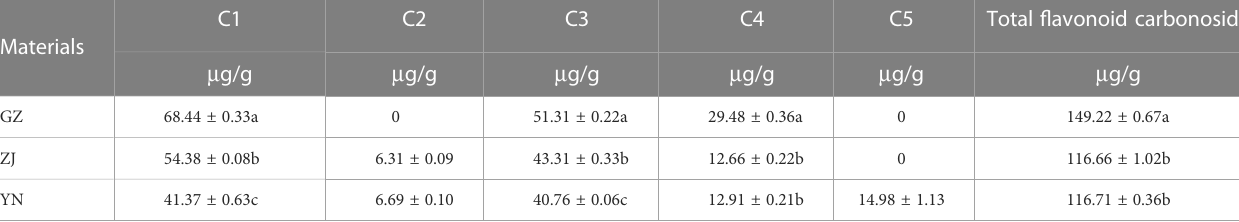
TABLE 2 Total fl avonoid carbonoside and reference substance content of D. of fi cinale from different provenances(C1-C5).